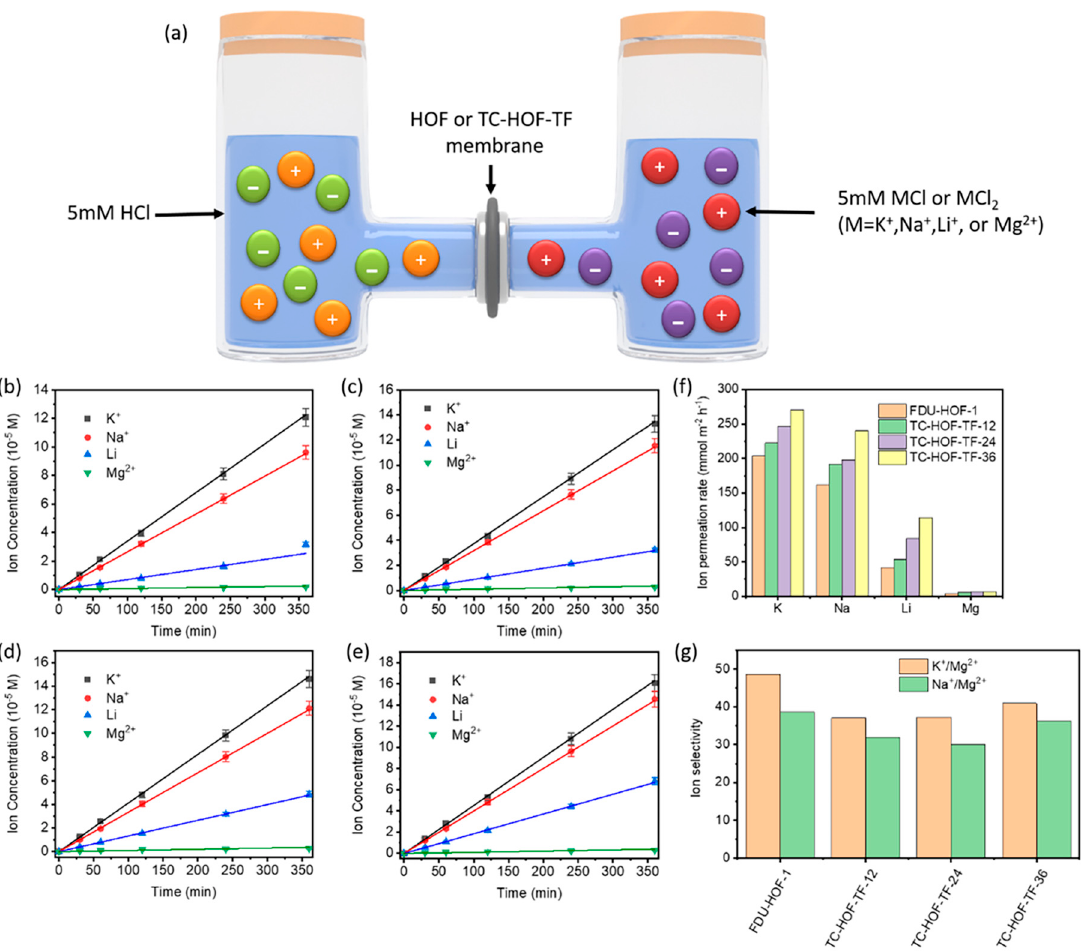
Figure 7. ( a ) Scheme of ion permeation experiments in a two-chamber cell. The ion concentration profiles of K + , Na + , Li + , and Mg 2+ over time for ( b ) FDU − HOF − 1, ( c ) TC − HOF − TF − 12, ( d ) TC − HOF − TF − 24, ( e ) TC − HOF − TF − 36 membranes. ( f ) The ion permeation rate and ( g ) ion selectivity of FDU − HOF − 1 and TC − HOF − TF membranes.